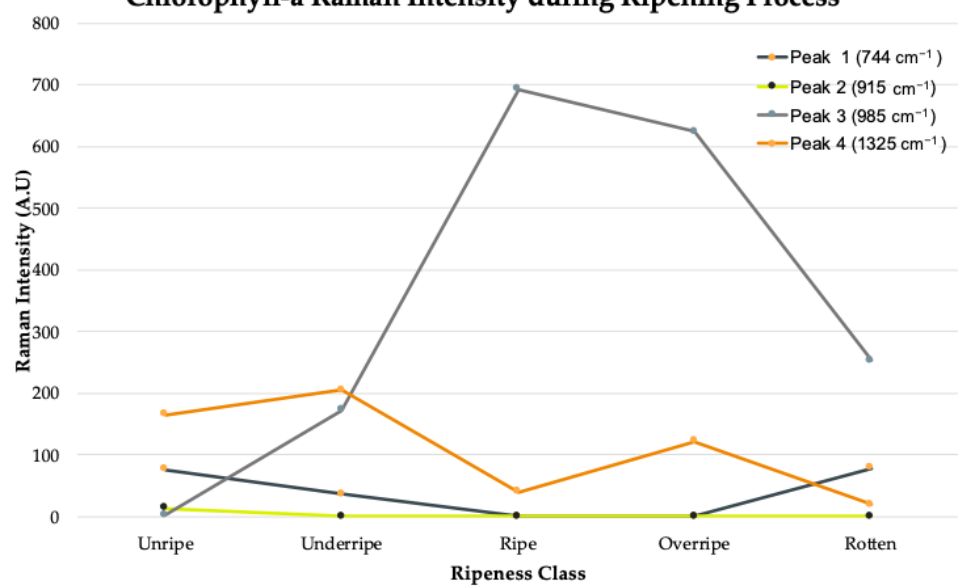
Figure 5. Trend sample A for Raman peak intensity value of chlorophyll-a in fresh oil palm fruit throughout ripening process.